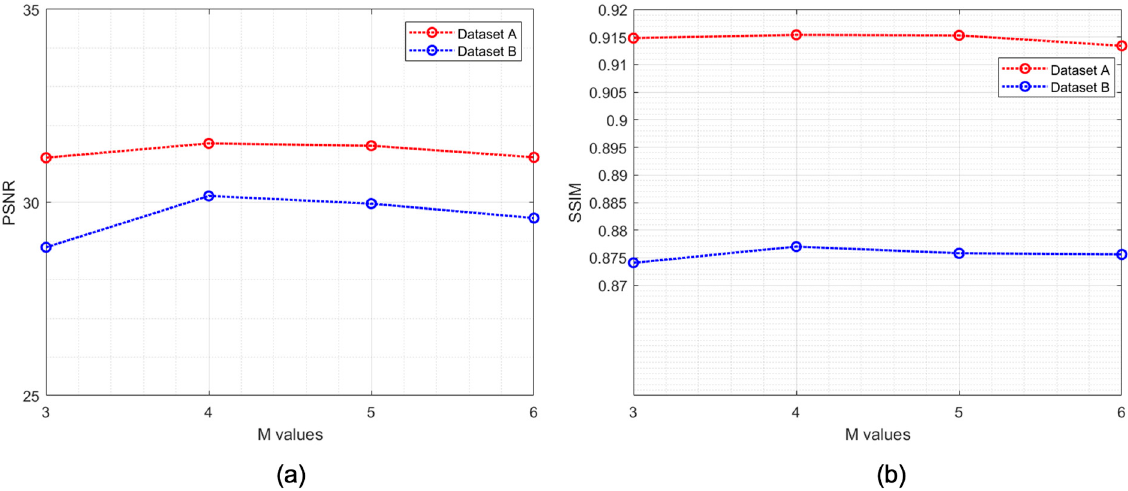
Figure 9. Graphical representation of the ( a ) PSNR [dB] and ( b ) SSIM with respect to the value of M .